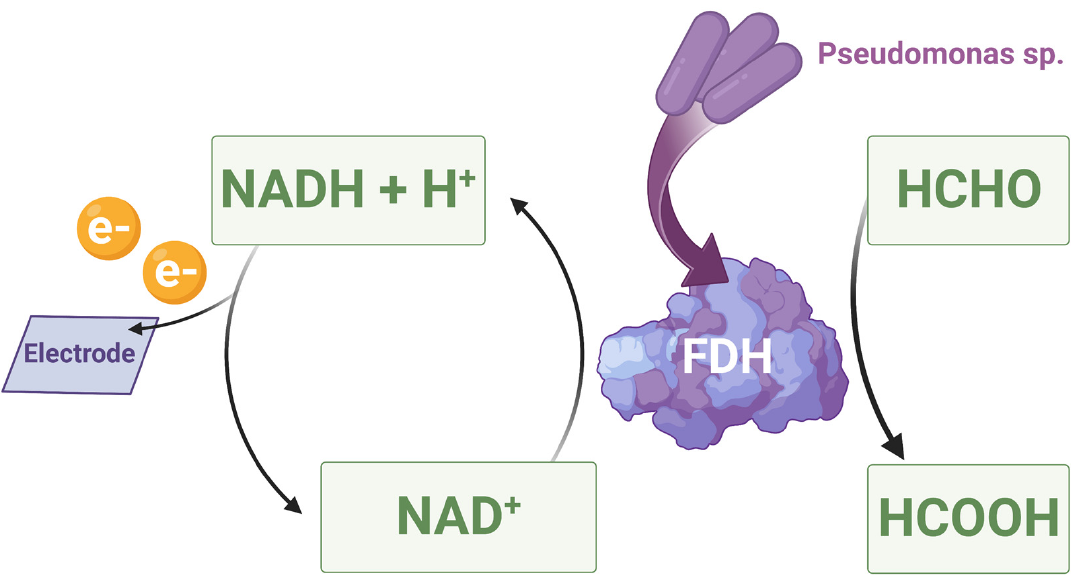
Figure 2. The mechanism of the operation of biosensors based on FDH derived from Gram-negative bacteria Pseudomonas sp.: FDH present in the biosensor oxidizes formaldehyde, resulting in the reduction of nicotinamide adenine dinucleotide (NAD+) to hydrogenated nicotinamide adenine dinucleotide (NADH) with an accompanying transfer of electrons, which make it possible to detect formaldehyde. Image created with biorender.com (accessed on 10 March 2023).